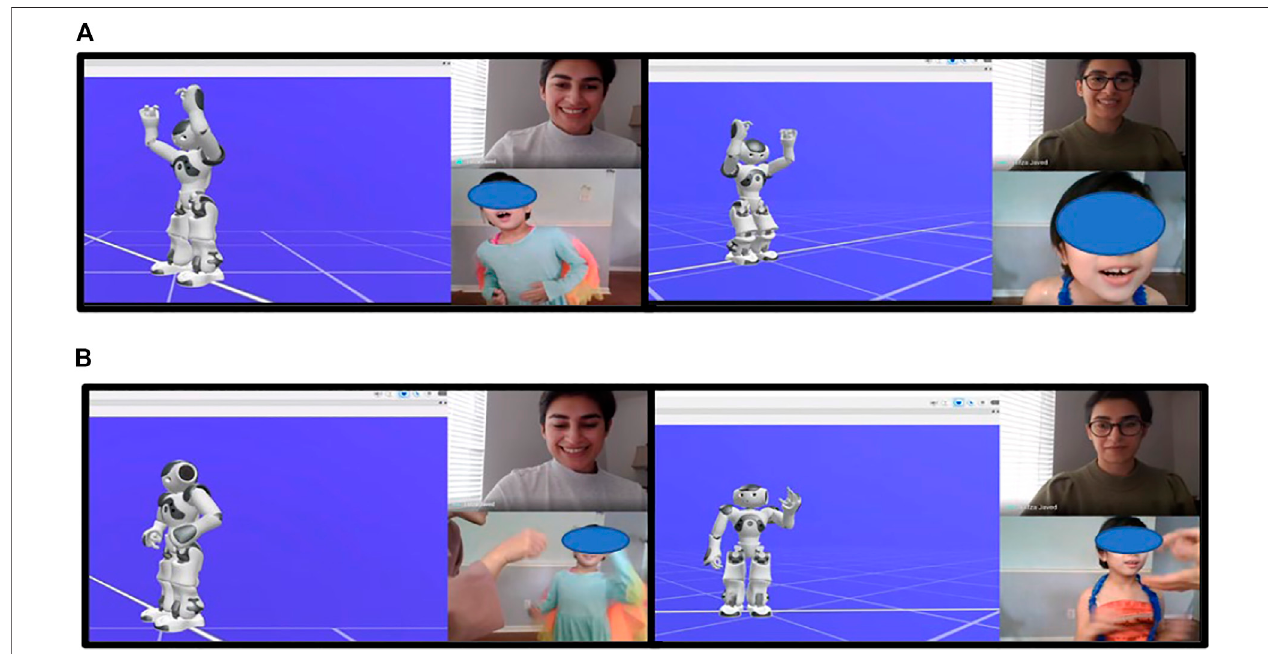
FIGURE 6 | Scenes depicting some important interaction events from our user study to evaluate the single-role versus mixed-role designs. (A) Participant shows fascinationwiththerobotcelebrations,and (B) Parentusestheendofaturntoencourageverbal+signingskillsintheparticipant(Writteninformedconsentwasobtained from the individual(s) AND/OR minor(s) ’ legal